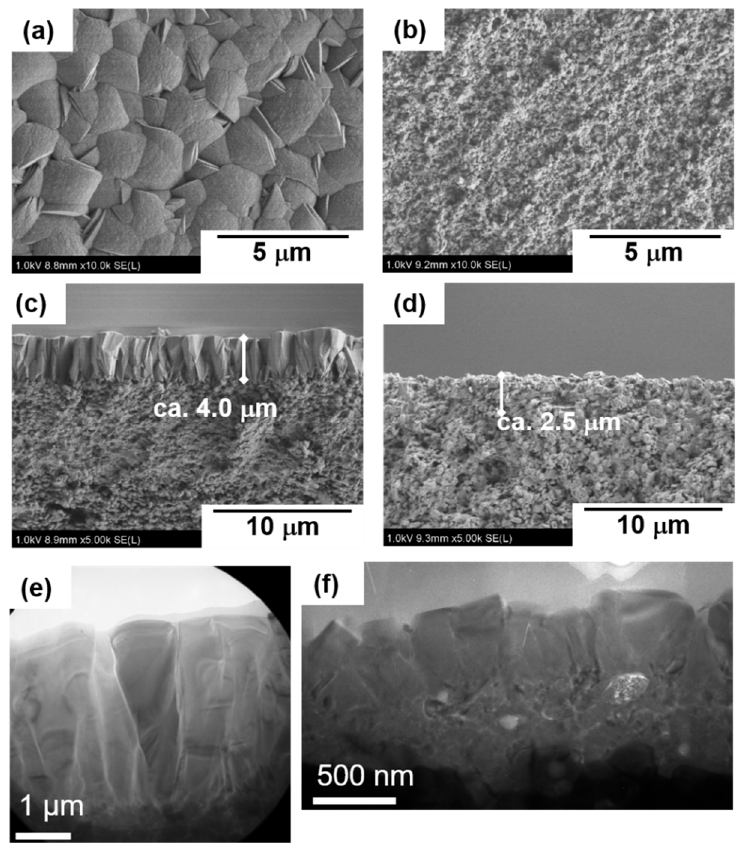
Figure 4. Typical FE-SEM images of silicalite-1 membranes. ( a , c , e ) S-1 S , ( b ,d, f ) S-1 M